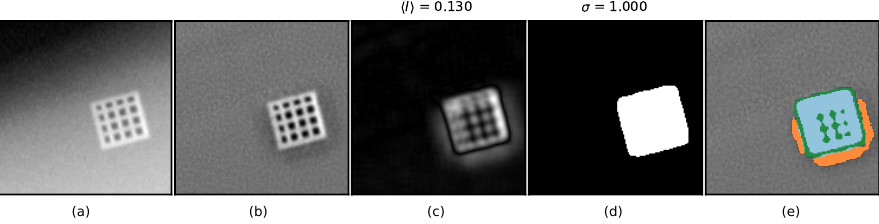
Figure 8. Results for the exotic synthetic raster anomaly. ( a ) is input, ( b ) is the residual image, residual analysis kernel results are for average kernel in ( c ) and standard deviation in ( d ). Above the patch is the maximum value indicated. Kernels above thresholds are indicated in ( e ) with blue ( (cid:104) I (cid:105) and σ ), green ( σ ), and orange ( (cid:104) I (cid:105) ). The residual image analysis results ( (cid:104) I (cid:105) and σ kernels) can also be indicated as his- tograms to indicate the level of separation between the classes. The histograms for